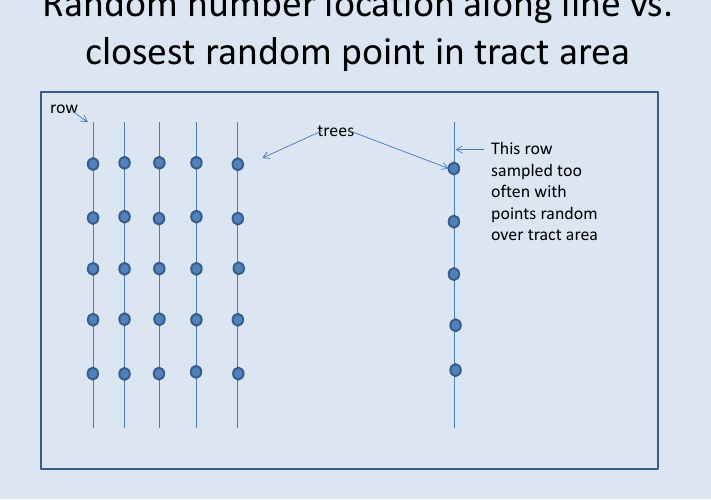
Figure 10. Illustration of a row population for which biases would occur if the random sample point is placed with uniform probability over a two dimensional land area rather than along the length of the plantation